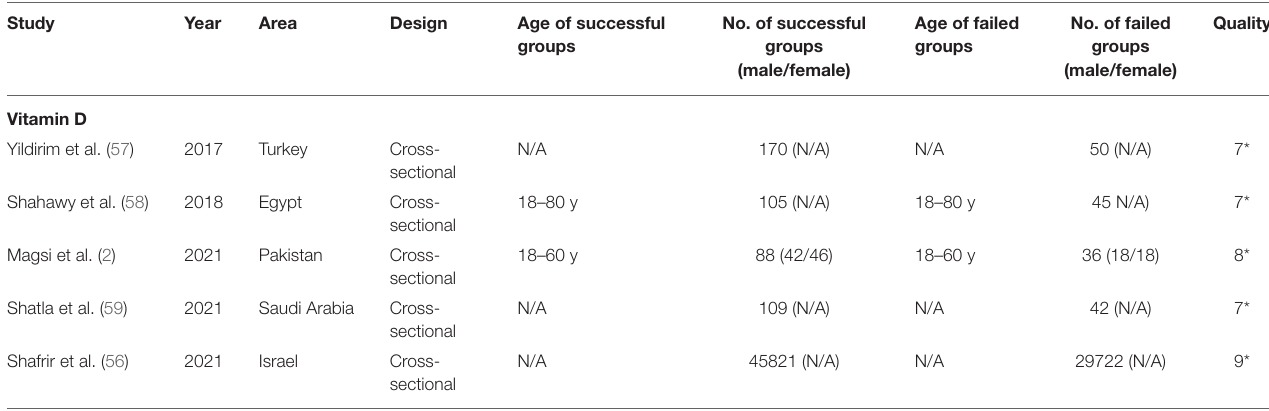
TABLE 2 | Basic characteristics of studies comparing serum vitamin levels between the successful H . pylori eradication groups and the failed groups.